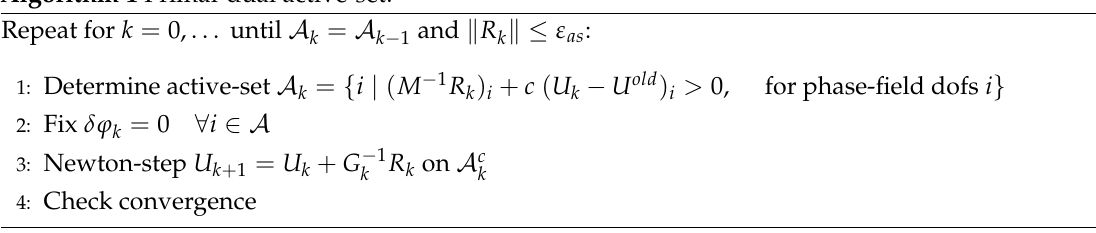
Algorithm 1 Primal-dual